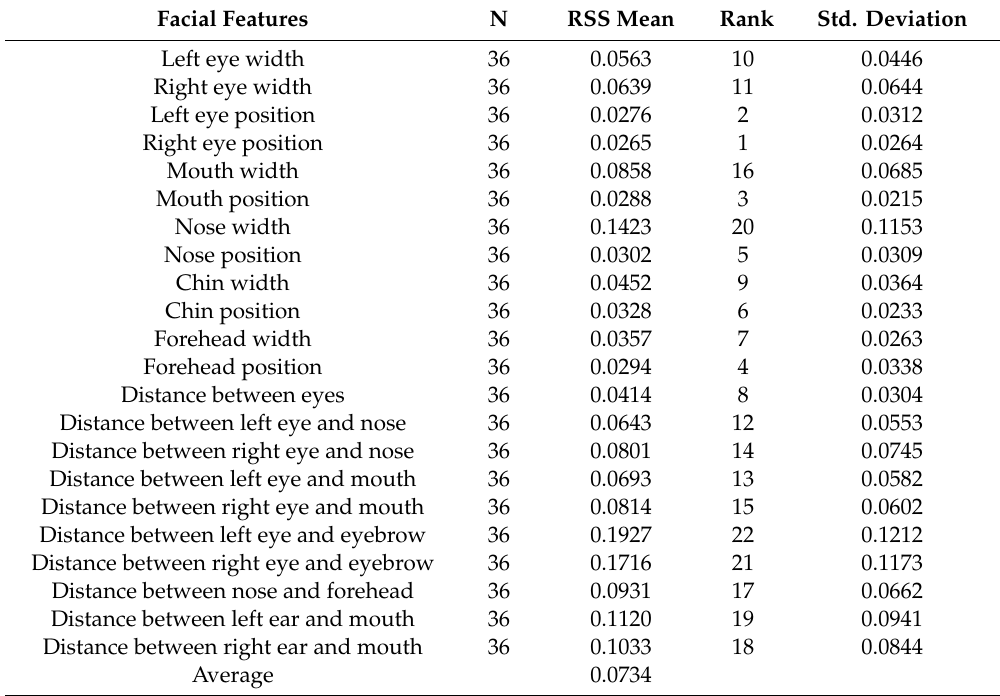
Table 5. The RSS means between surprise expression and neutral mode of 22 facial features for 36